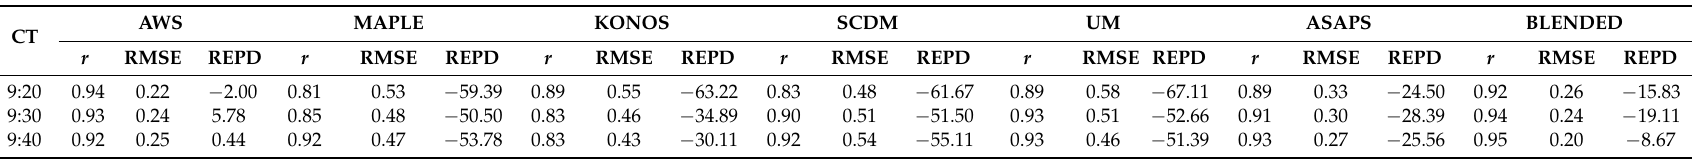
Table 3. Evaluation results for simulated water depth using various QPF products (Case 3) in terms of correlation coefficient ( r ), relative error of peak depth (REPD), and root mean square error (RMSE) by current time